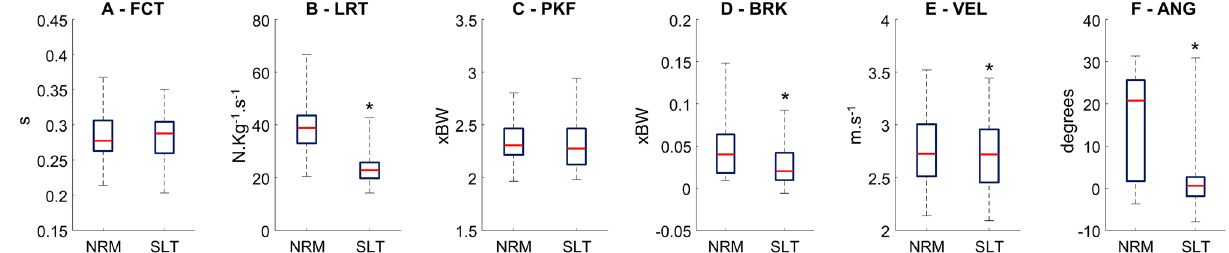
Figure 2. Comparison normal (NRM) vs silent running (SLT) for foot contact time (FCT, A ), vertical loading rate (LRT, B ), peak vertical force (PKF, C ), peak braking force (BRK, D ), running speed (VEL, E ) and foot contact angle (ANG, F ). Box plots represent 25th and 25th percentiles, and data range ( dashed vertical lines ) during normal (NRM) and silent running (SLT). * denotes a significant difference in relation to normal running ( p < 0.05).